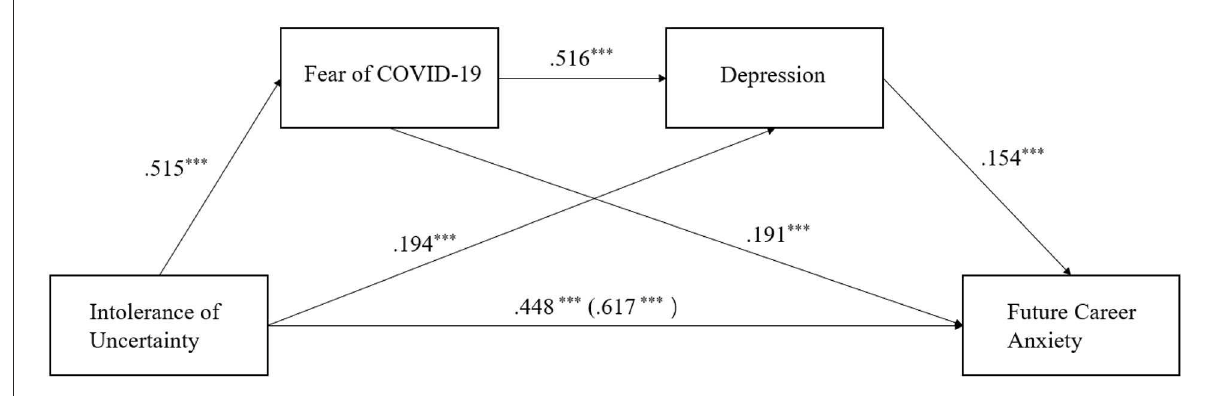
FIGURE2 The chain mediation model. Note. *** p < 0.001.